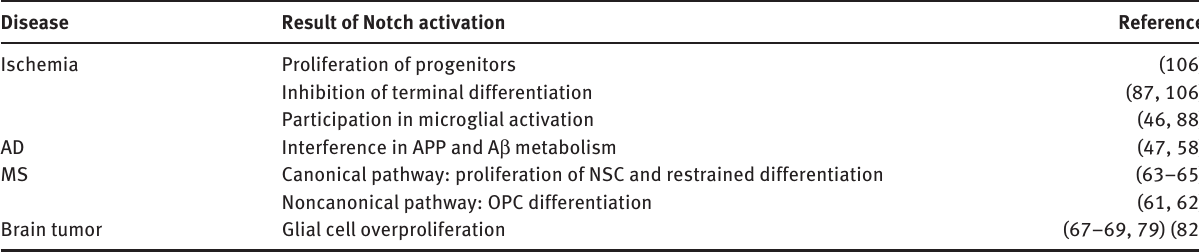
Table 2 Consequences of Notch activation in neurological diseases.